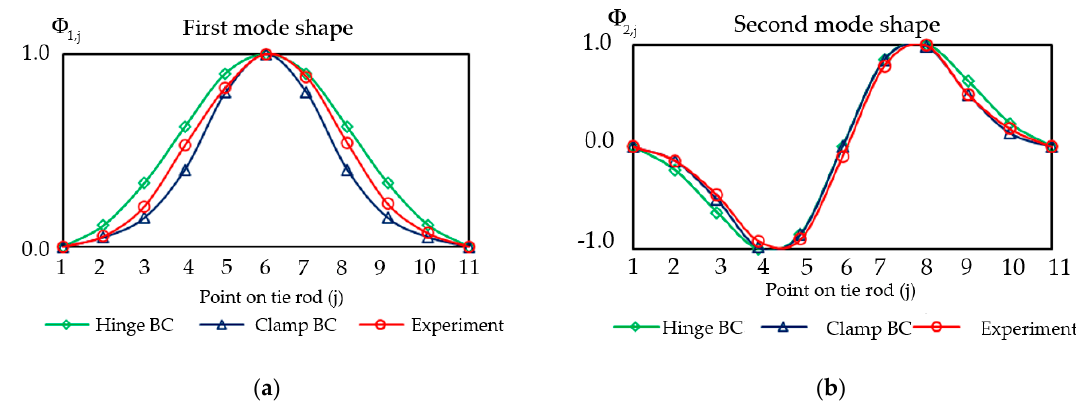
Figure 11. Comparison of the experimental mode shapes of the reference tie rod 6B ‒ C and the mode shapes associated initial numerical models for the ( a ) first and ( b ) second mode shapes.